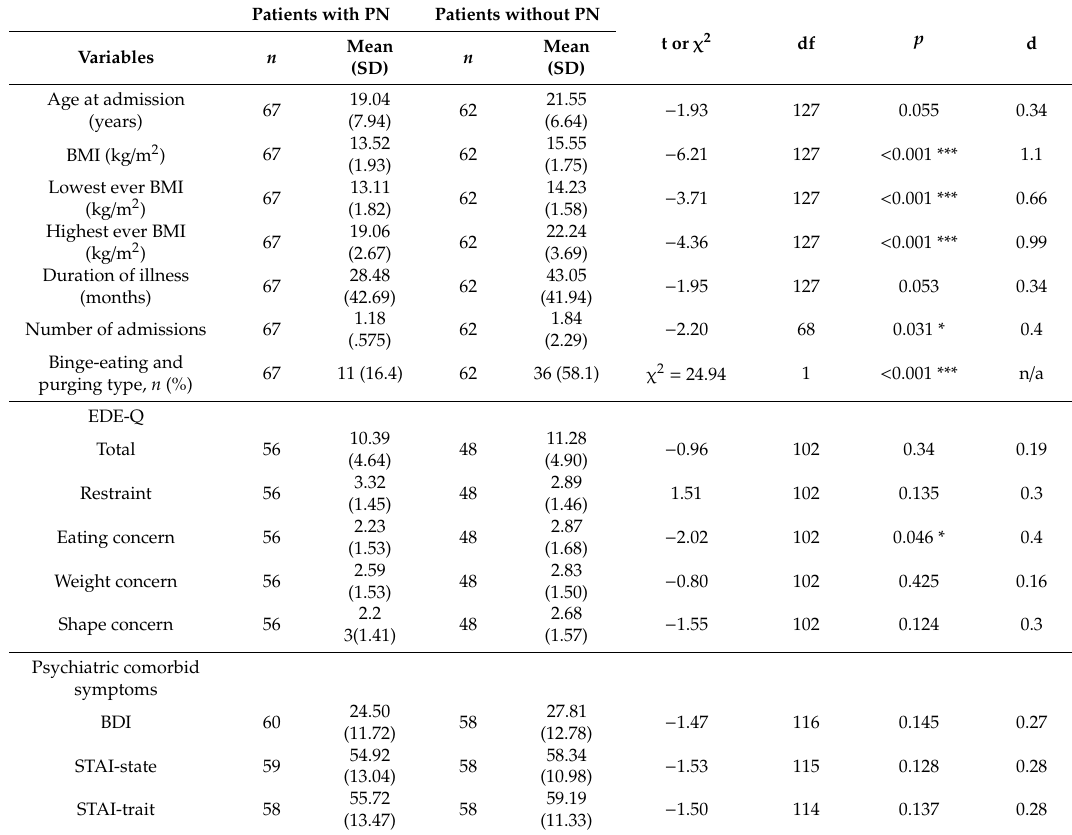
Table 1. Clinical characteristics of AN patients with anorexia nervosa at admission. Patients with PN Patients without